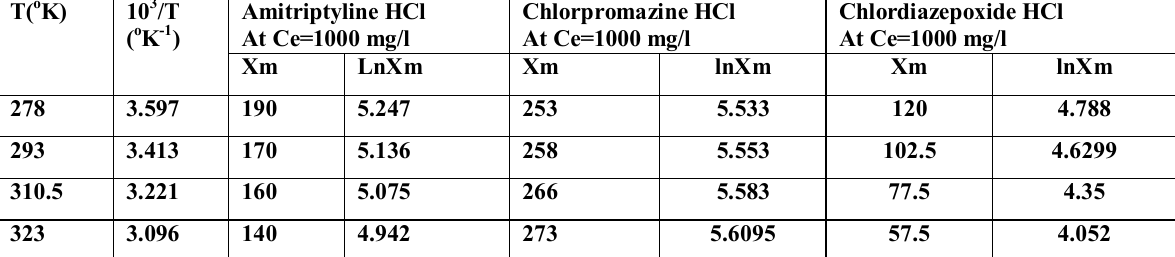
Table 1: Effect of temperature on the maximum adsorption of the drugs on bentonite